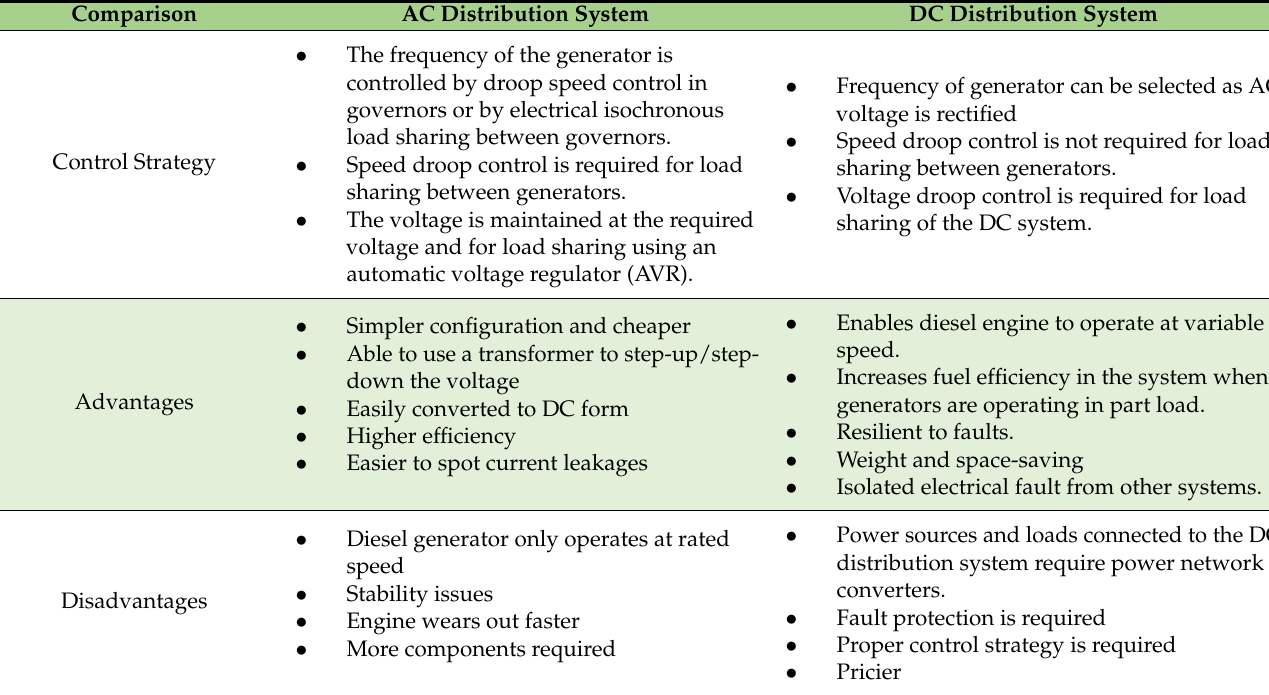
Table 1. Comparison of AC and DC distribution